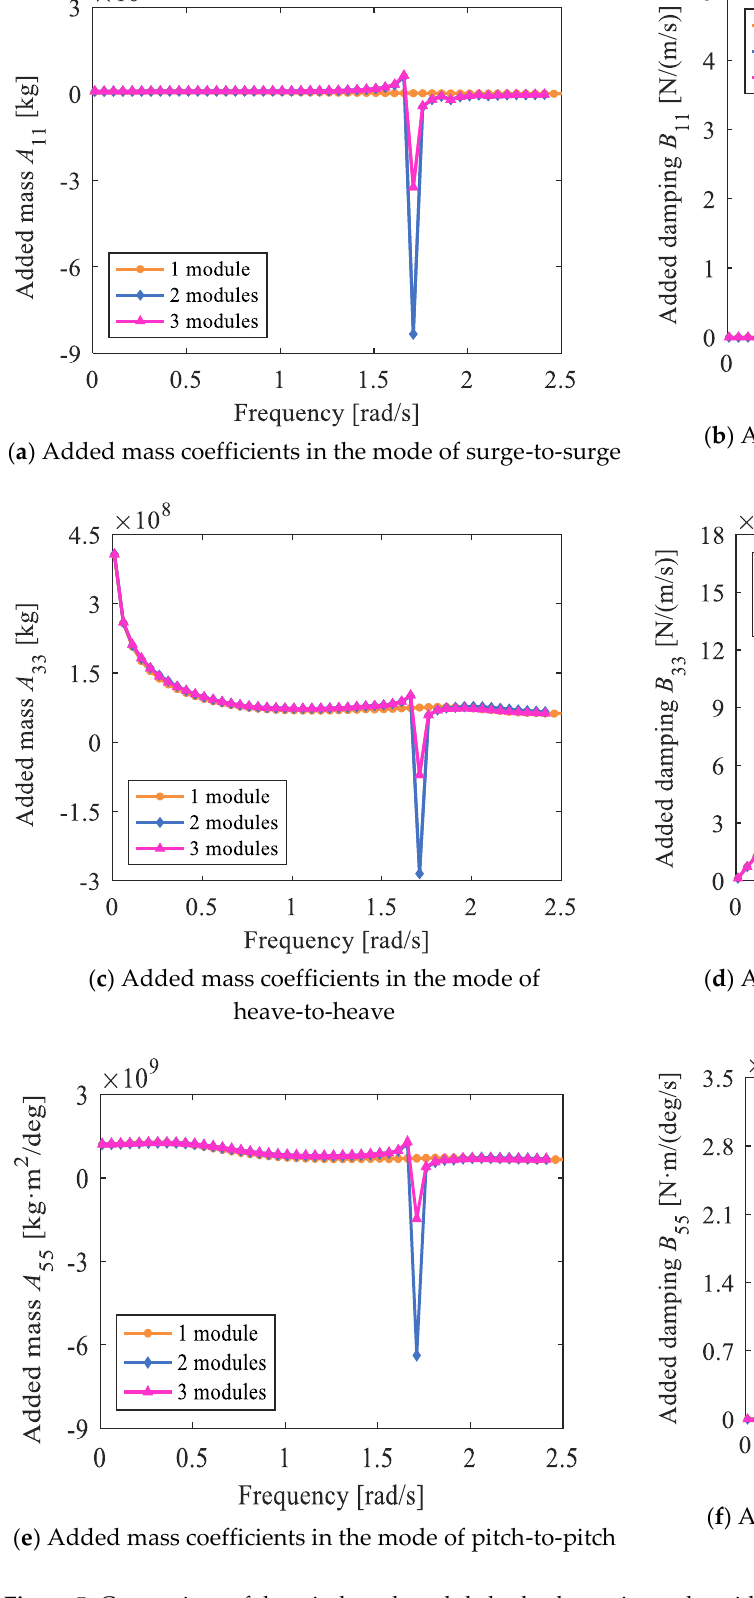
Figure 5. Comparison of the windward module hydrodynamic results with the change of the number of floating bodies (wave angle = 180 ◦